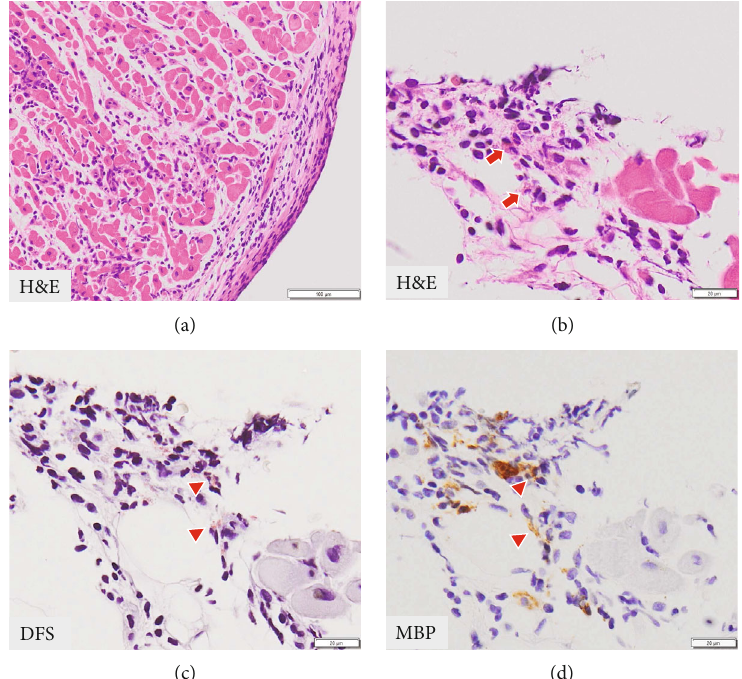
Figure 2: Right ventricular myocardial biopsy specimen. (a) Extensive in fl ammatory cell in fi ltration (consisting of lymphocytes and no giant cells) with little necrosis (hematoxylin-eosin (H&E) staining); (b) a few eosinophils (red arrow) with degranulation can be observed (H&E staining); (c, d) eosinophil degranulation (red arrowhead) con fi rmed by direct fast scarlet (DFS) staining and immunostaining for major basic protein (MBP).